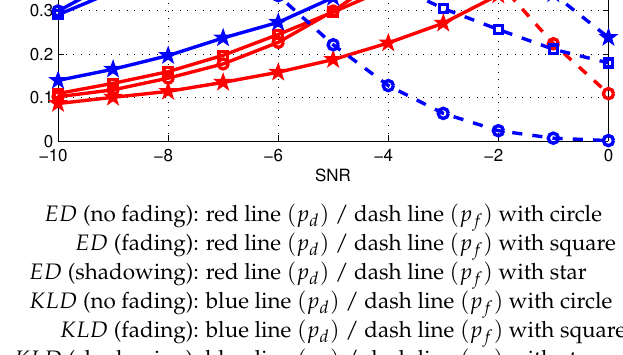
Figure 4. Detection and false alarm probabilities at the FC of the proposed and conventional schemes under various channels with N s =